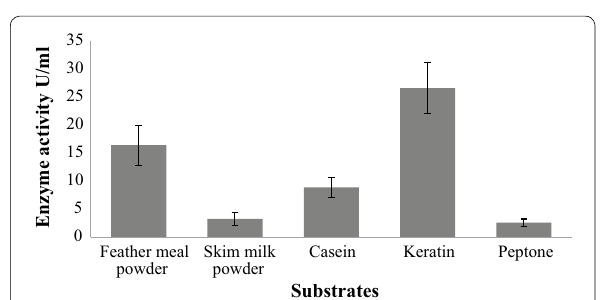
Fig. 3 Effect of different substrates on keratinase production by Arthrobacter sp. NFH5. The fermentation was carried out at 37 °C with pH 7.5 at 150 rpm for 72 h. Data represent the means deviations for triplicate